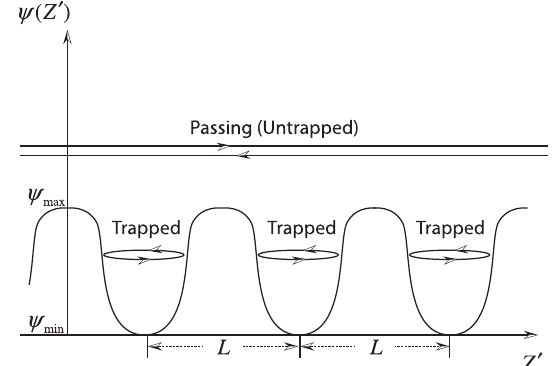
FIG. 12. Illustrative plot of the effective potential ψ ð Z 0 Þ versus Z 0 for the case where ψ ð Z 0 Þ has a nonlinear periodic waveform with ψ ð Z 0 þ L Þ ¼ ψ ð Z 0 Þ , where L is the periodicity length. In the figure, passing particles with energy W 0 > ψ whereas particles with energy ψ exhibit periodic motion in the potential ψ ð Z 0 Þ